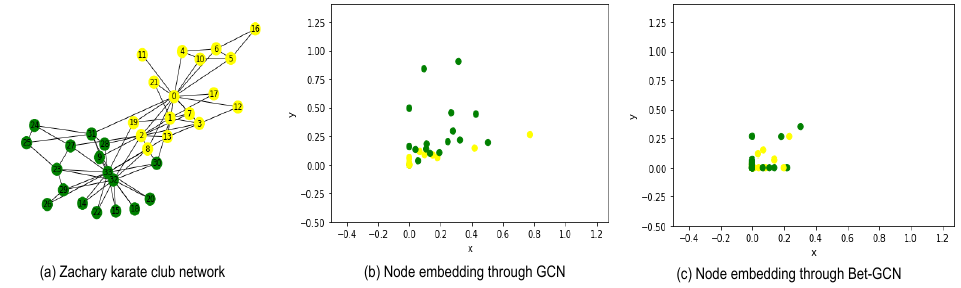
Figure 6. Node embedding of GCN and GCN with betweenness